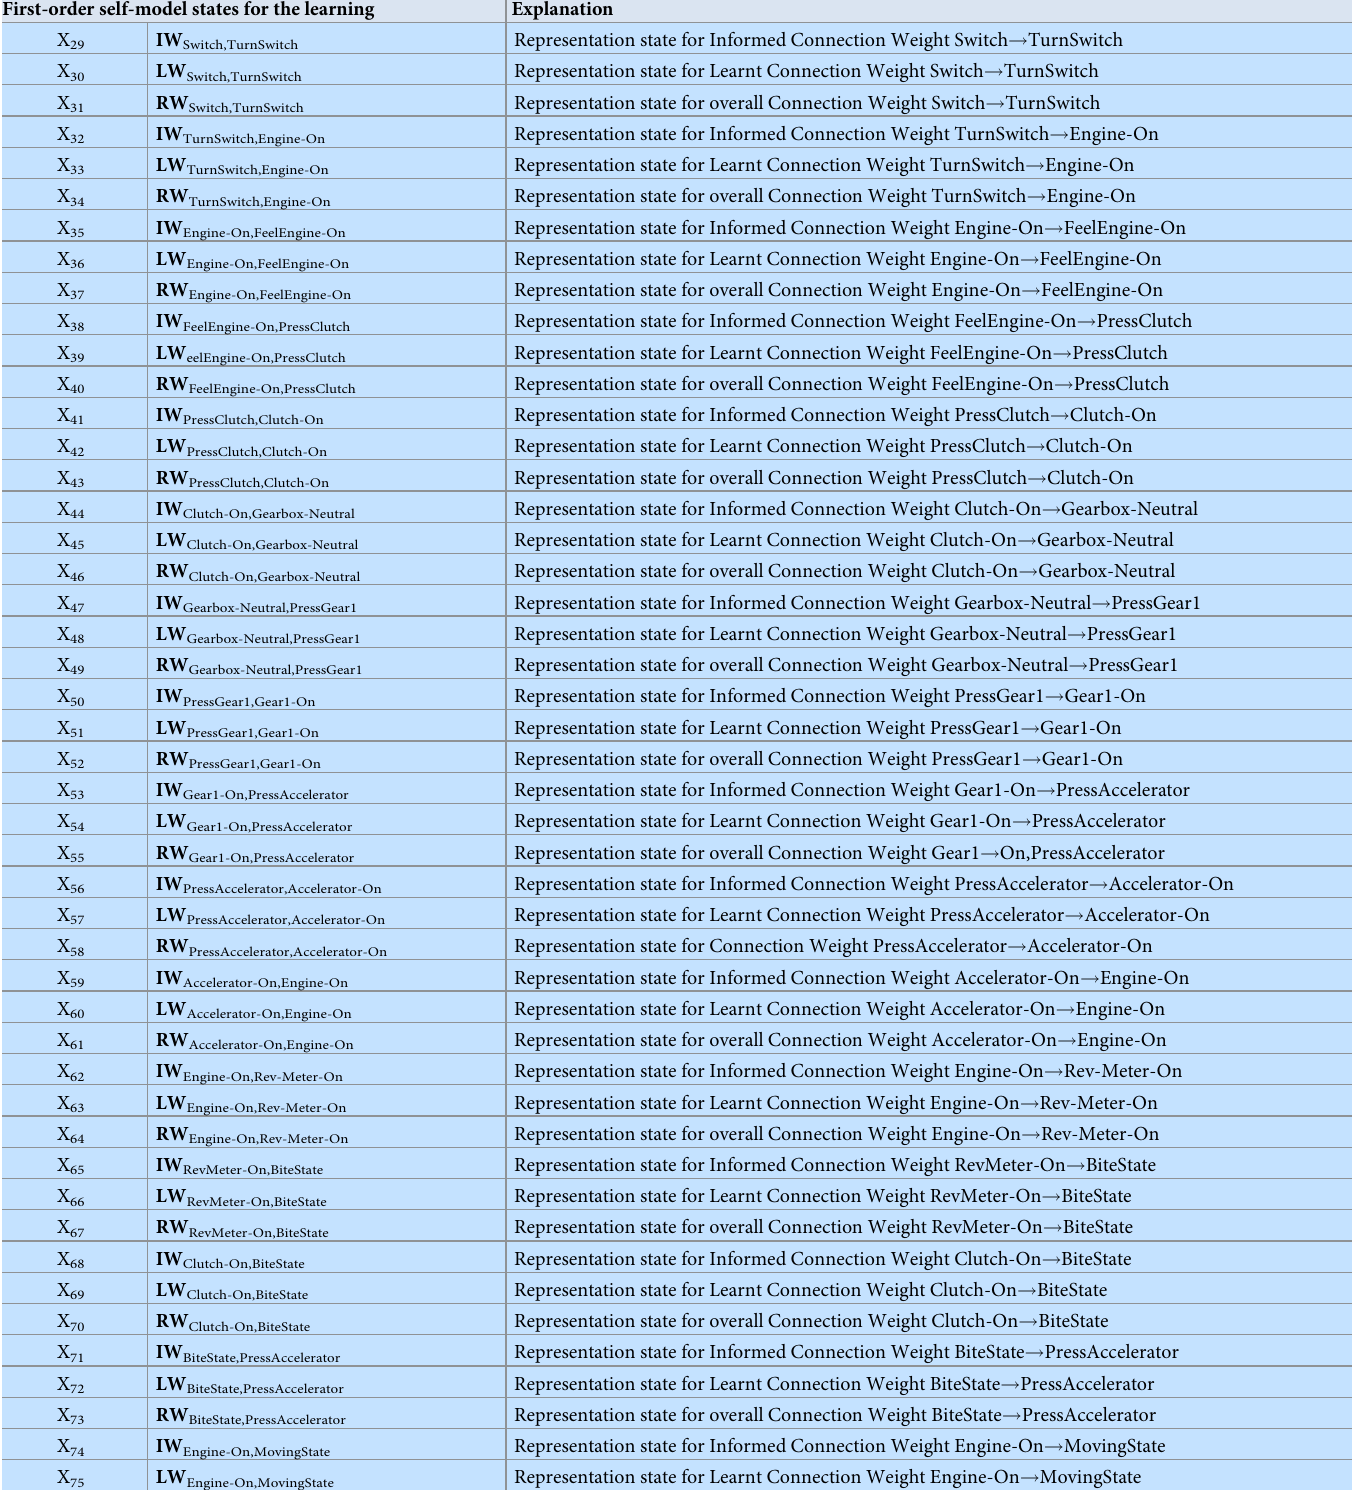
Table 4. Explanation of the first-order self-model states for the mental model learning in the network model. First-order self-model states for the